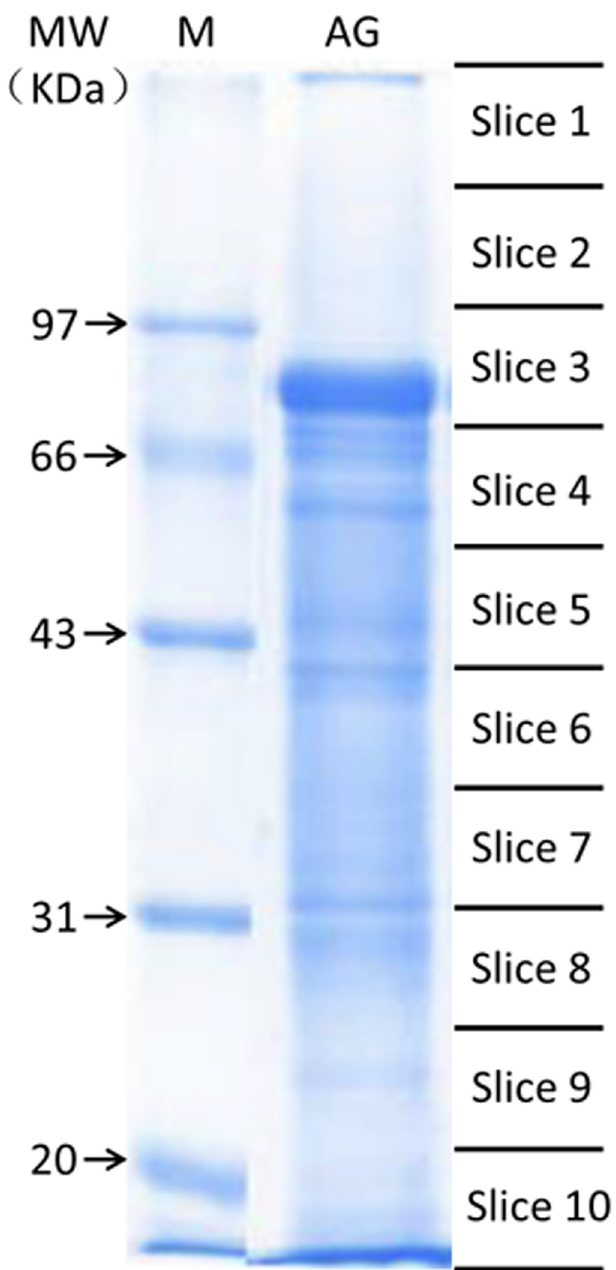
Fig 2. SDS-PAGE pattern of AG proteins in E . sinensis . AG proteins (30 μ g) were separated using 10 cm 12% SDS-PAGE gels for 1 h at 120 V. The gel was stained with Coomassie Brilliant Blue G250 (Invitrogen) and the protein lane of the stained gel was cut into ten pieces of equal